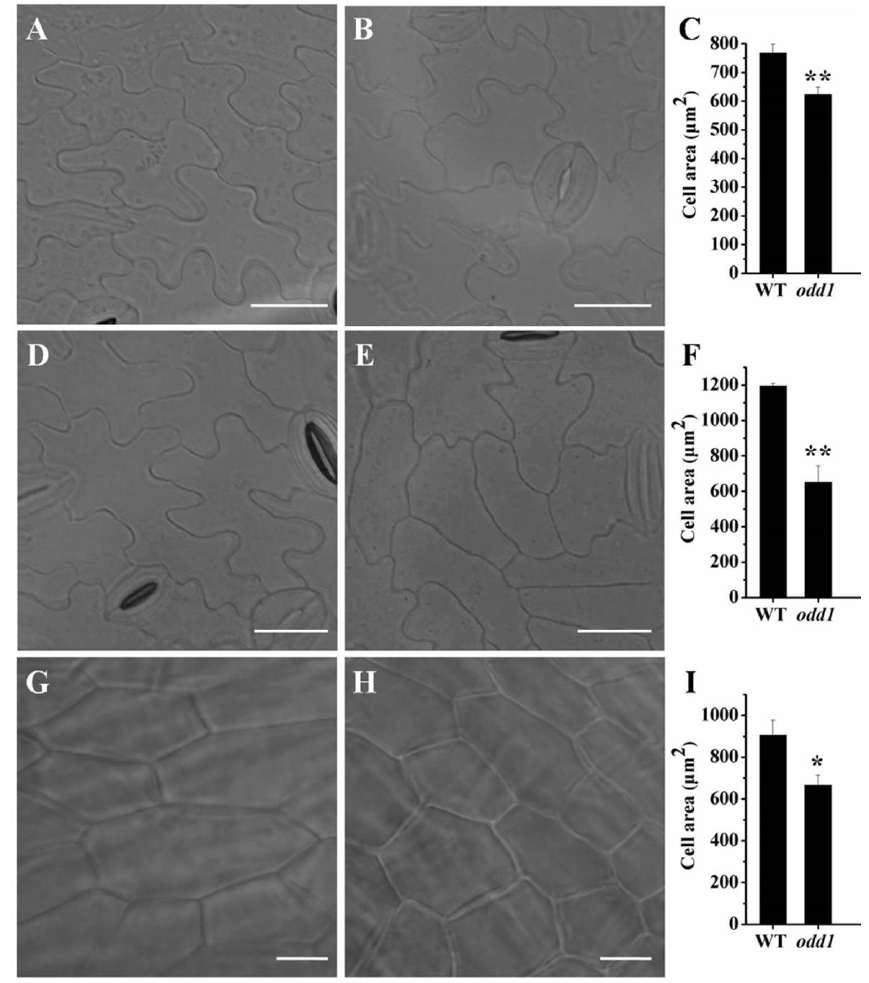
Figrue 6 Figure 6. Comparison of the cell morphology between WT and odd1 . ( A – C ) The cell shape and size of the cotyledon between WT ( A ) and odd1 ( B ), and the corresponding quantifications of cell size ( C ). ( D – F ) The cell phenotype of the fourth functional leaf counting from the plant apex of WT ( D ) and odd1 ( E ), and the respective quantifications of cell size ( F ). ( G – I ) Petal cells at anthesis of WT ( G ) and odd1 ( H ), and the respective quantifications of cell size ( I ). Asterisk indicates that the cell size in WT is significantly larger than that in odd1 (single asterisk, p = 0.05; two asterisks, p = 0.01). The bars in ( C , F , I ) represent the standard deviation (n = 6). Scale bars represent 20 µ